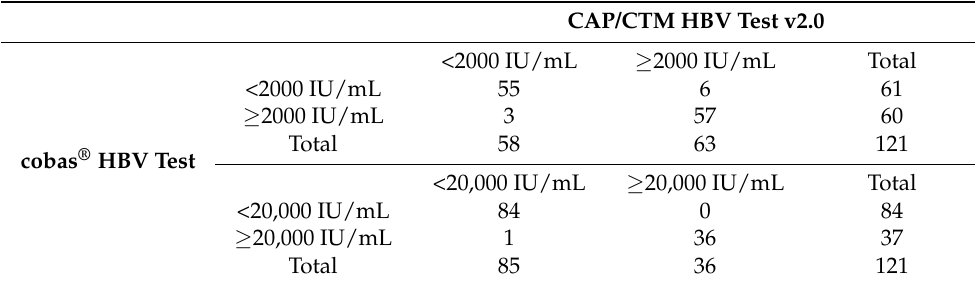
Table 1. Concordance at the 2000 and 20,000 UI/mL clinically relevant cutoffs between the cobas ® HBV test and CAP/CTM HBV Test v2.0.